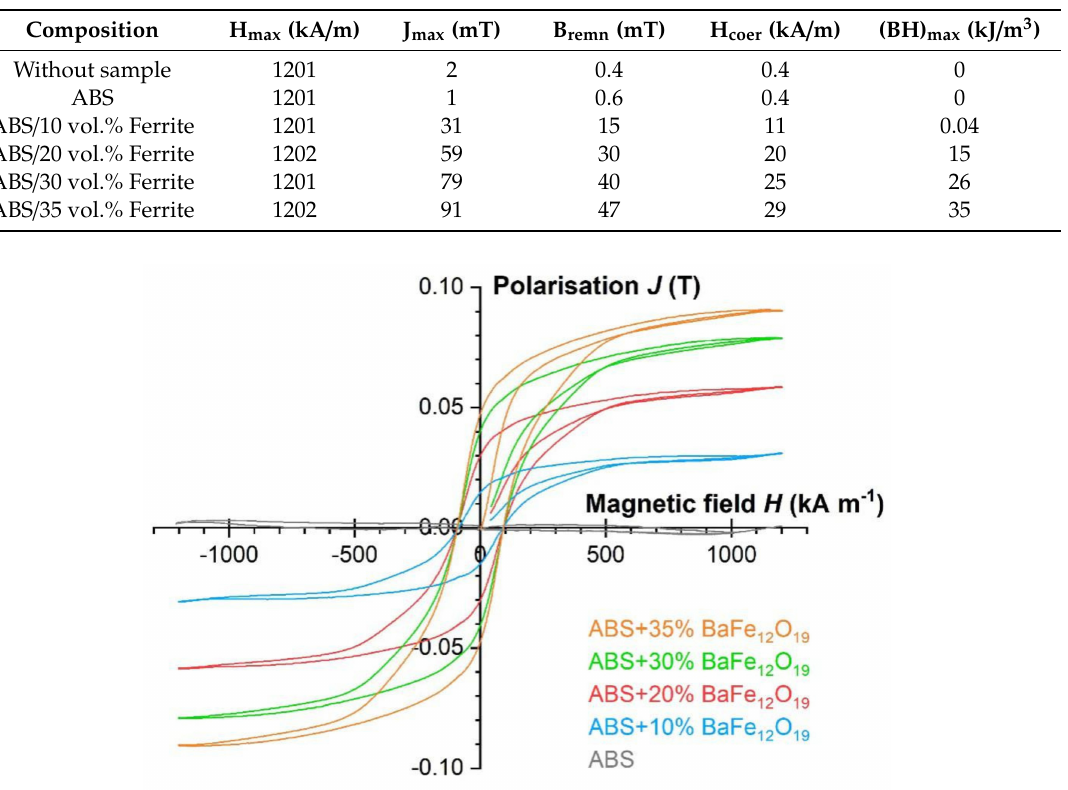
Figure 9. Change of the magnetic polarization as function of the applied magnetic field and ferrite